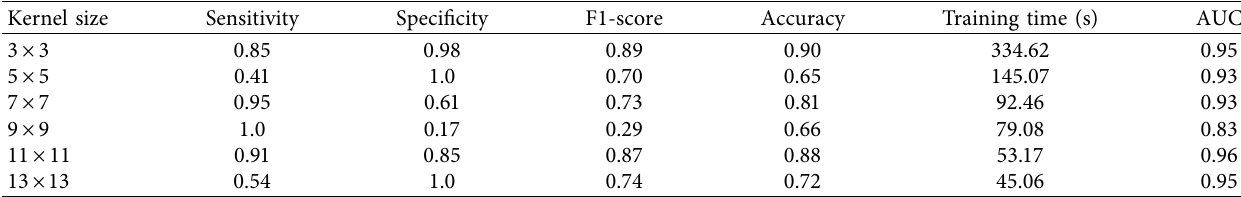
Table 7: Test results for Spambase dataset.